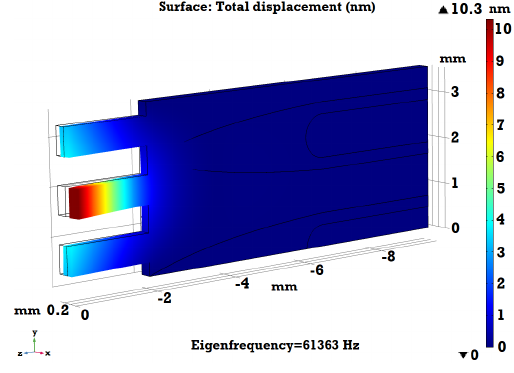
FIGURE 17. Mechanical Deformation (nm) at First Mechanical